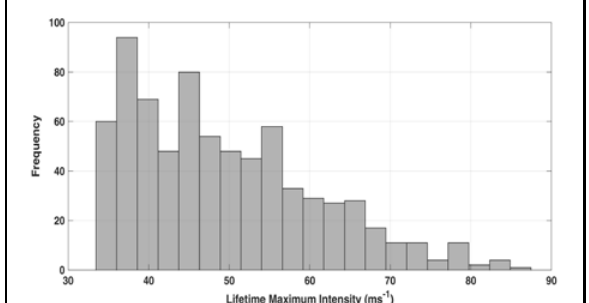
Figure 4. Histogram of LMI for hurricanes in the ACR.